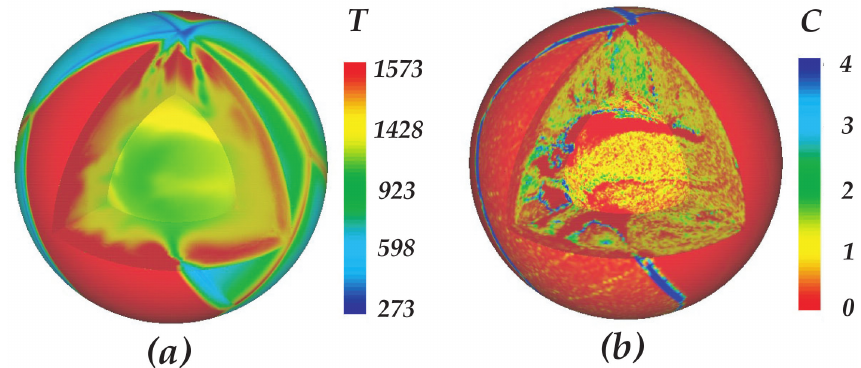
Fig. 9. Cut-away images of (a) temperature and (b) tracer concentration in a three-dimensional spherical model of mantle stirring with heavy tracers. After Huang and Davies (2007b). Copyright American Geophysical Union.